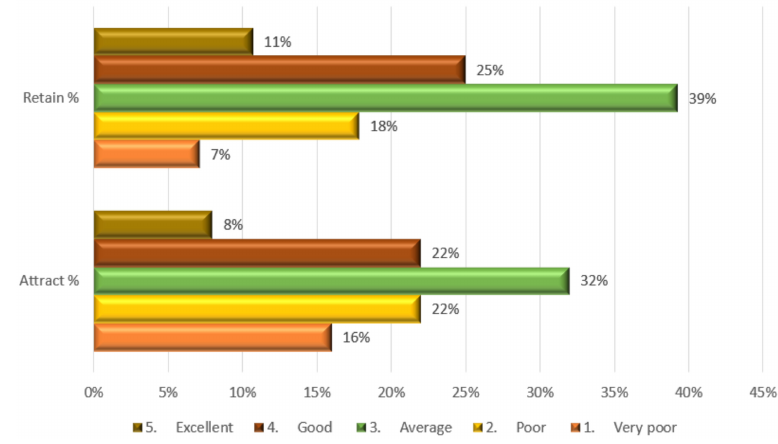
Figure 2. Rating of retention